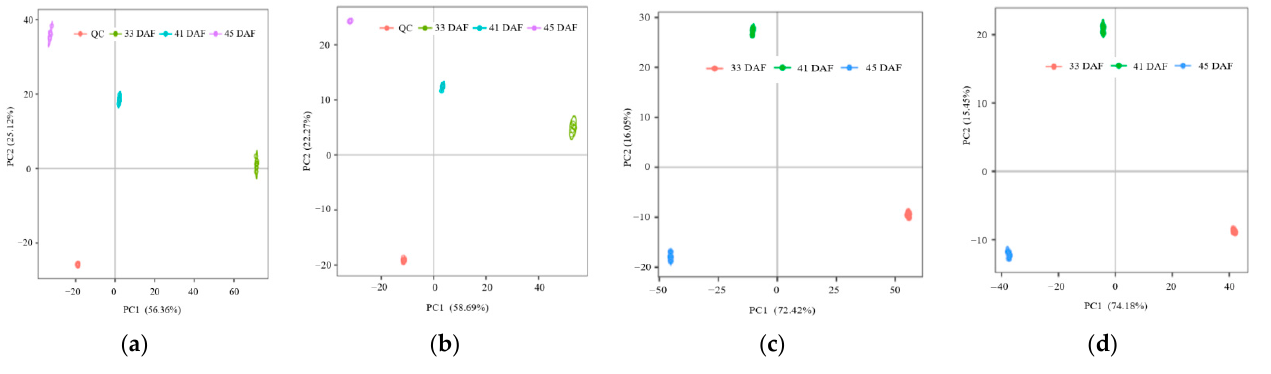
Figure 3. Assessment of repeatability and variability of samples from the same period. ( a ) Principle component analysis (PCA) in EIS+ mode; ( b ) PCA in EIS − mode; ( c ) Partial least squares method-discriminant analysis (PLS-DA) in EIS+ mode; ( d ) PLS-DA in EIS − mode. The horizontal axis is the first principle component (PC) and the vertical axis is the second PC, and the ellipse in the PCA score graph is 95% confidence interval. Each dot represents a sample, with different colors for different groups. The number in parentheses is the score of the PC, indicating the ability of the PC to interpret the whole model.